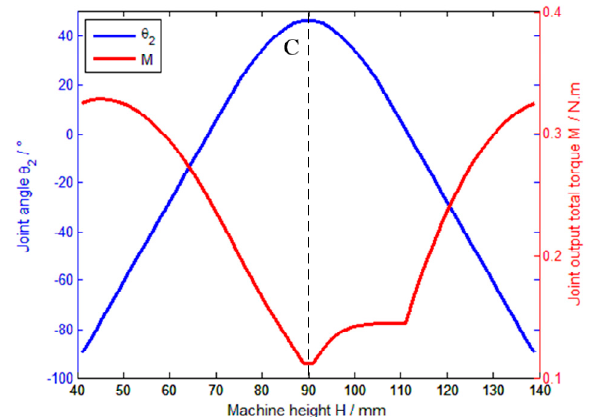
Figure 11. Relationship between joint angles θ 1 and θ 2 under different values of θ 3 .